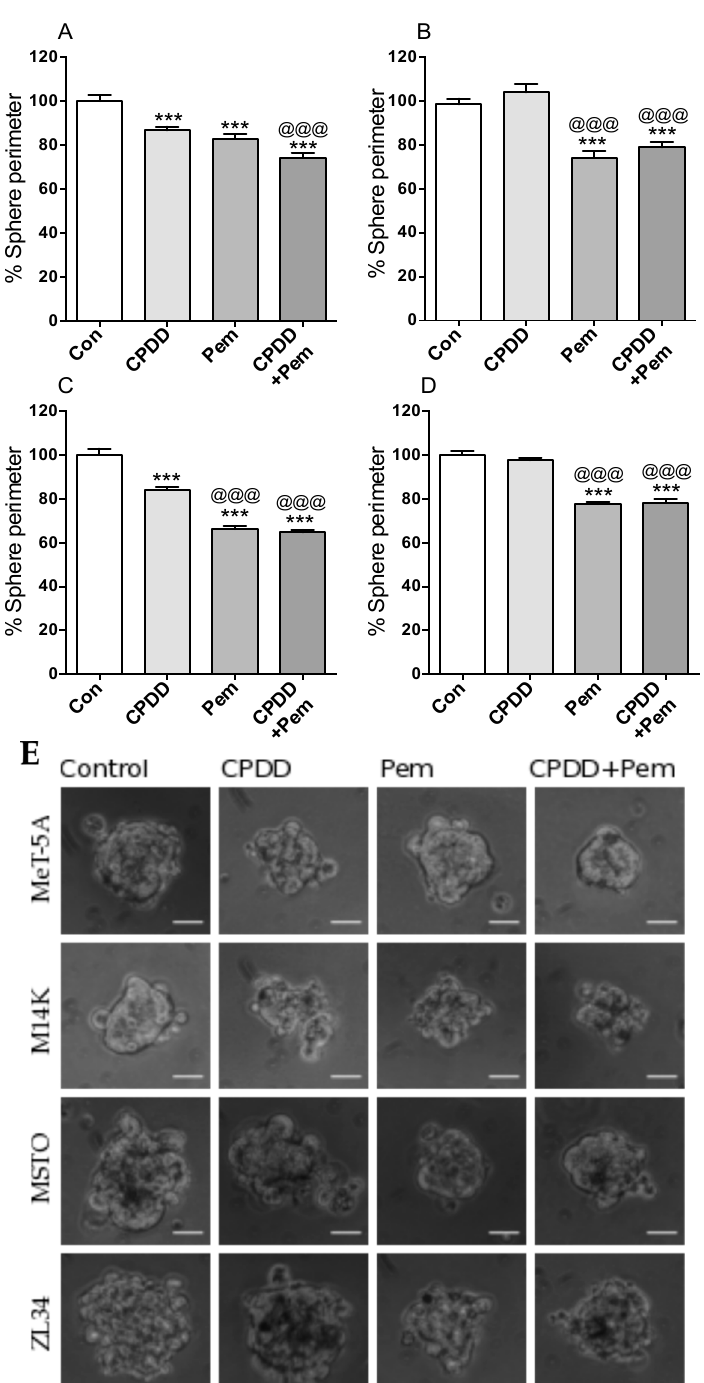
Figure 2. Mean values of spheroid perimeter ± SEM without or with treatments (CPDD, Pem, or CPDD + Pem) expressed as % of Controls (cells with 10% FBS-RPMI), along with representative microscopy images from each group. ( A ) MeT-5A cells ( n = 13–17), ( B ) M14K cells ( n = 10–15), ( C ) MSTO cells ( n = 15–18), ( D ) ZL34 ( n = 13–15). *** p < 0.001 vs. Controls, @@@ p < 0.001 vs. CPDD. ( E ) Images of spheroids of cell types arranged by rows and their corresponding treatments in a column wise manner. Scale bars represent a length of 100 pixels.